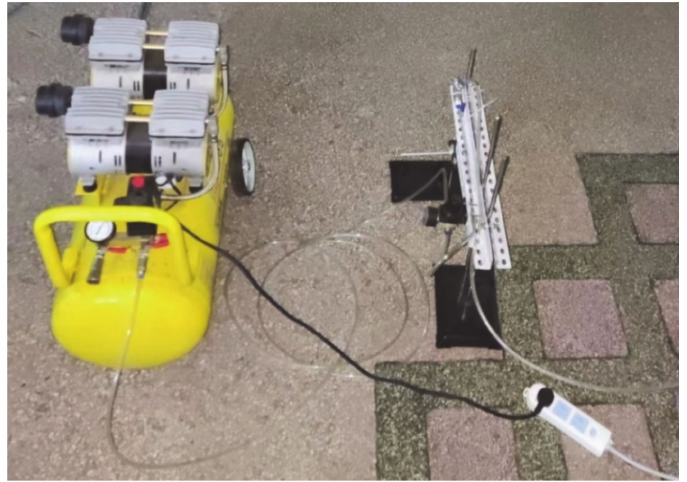
Figure 9. Primary experimental instruments for the wind resistance experiment.